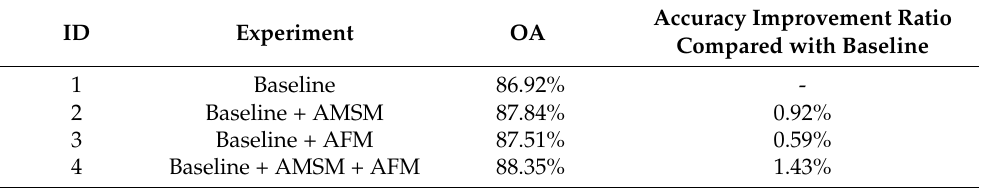
Table 2. Comparison between the baseline and the baseline with the corresponding model added.